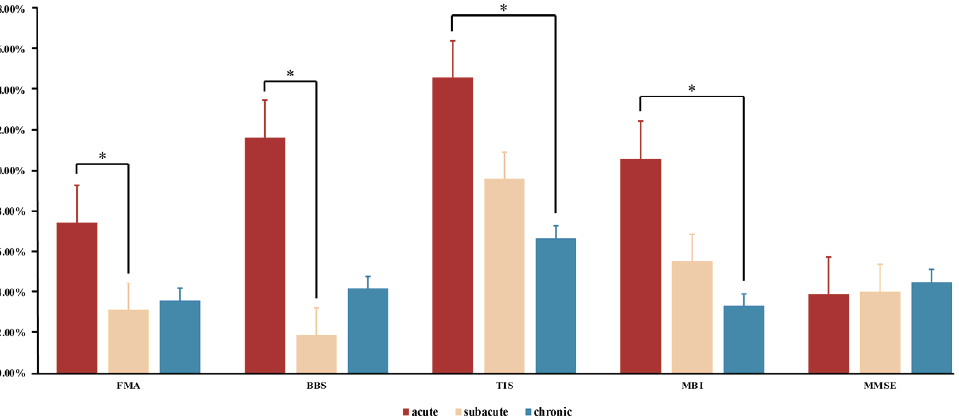
Figure 3. Clinical outcome variables after Walkbot RAGT in acute, subacute, and chronic stroke patients. * p < 0.05, Bonferroni’s post hoc test.